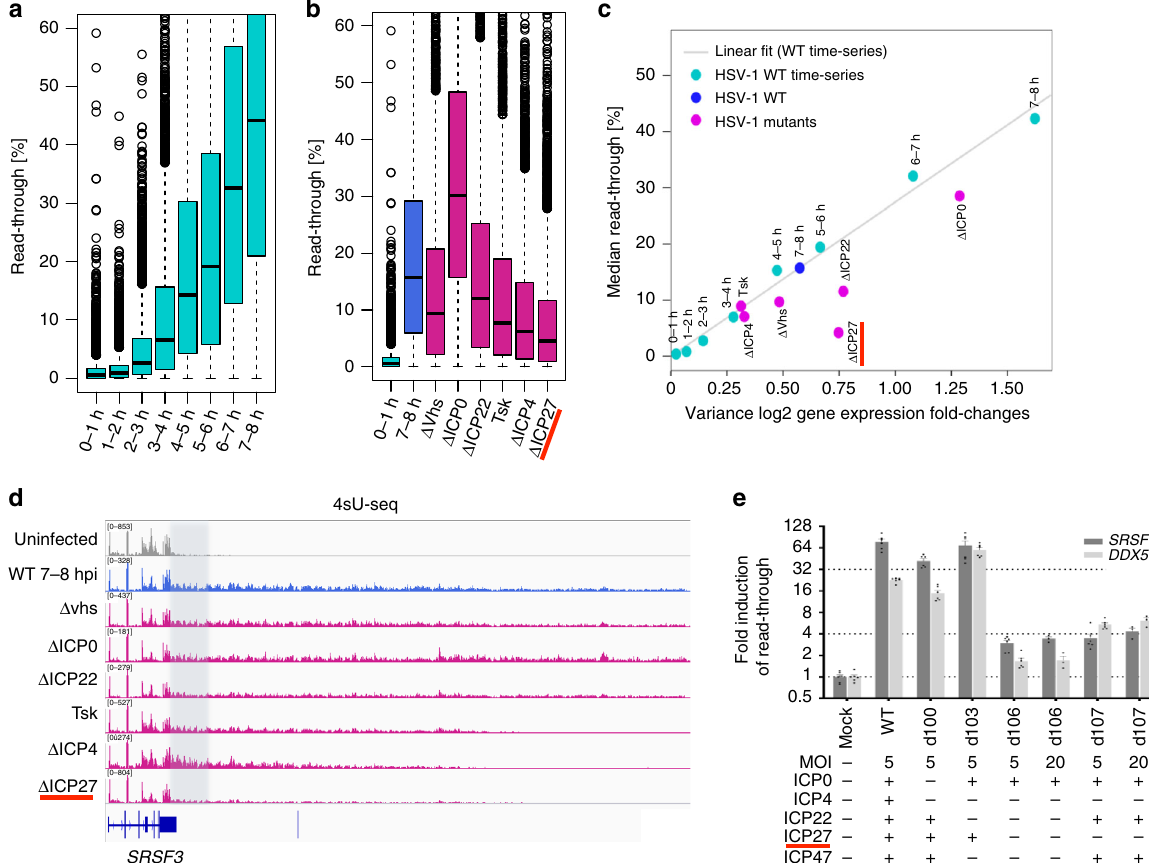
Fig. 1 ICP27 is a major contributor for HSV-1-induced disruption of transcription termination. a Boxplots showing the distribution of read-through at different time points post-infection during HSV-1 wild-type infection (time-course). b Boxplots showing the distribution of read-through in cells infected with wild-type and various mutant viruses at 7 – 8 h (WT, Δ vhs, Δ ICP4, Δ ICP27) and 11 – 12 h ( Δ ICP22, Δ ICP0) post-infection. Please note that read-through at 7 – 8 h post-infection shown here is from a repeat experiment performed together with the mutant viruses. Read-through at 0 – 1 h post-infection from the WT time-course is also shown. c Median read-through values for each condition and time-point are plotted against the variance in log2 gene expression ( = gene FPKM) fold-changes. The gray curve indicates the result of linear fi t on all HSV-1 infection time-points from the time-course experiment. d Mapped 4sU-seq reads for SRSF3 in cells infected with wild-type or various mutant HSV-1 strains. The region where transcription termination occurs in mock- infected cells is shaded. e Primary human fi broblasts infected were infected for 8 h with mutant viruses lacking various immediate early genes. The genes that are still expressed by the individual mutants as well as the employed multiplicity of infection are indicated in the table below the graph. Read-through transcription was quanti fi ed by qRT-PCR data and plotted as mean ± s.e.m. ( n =